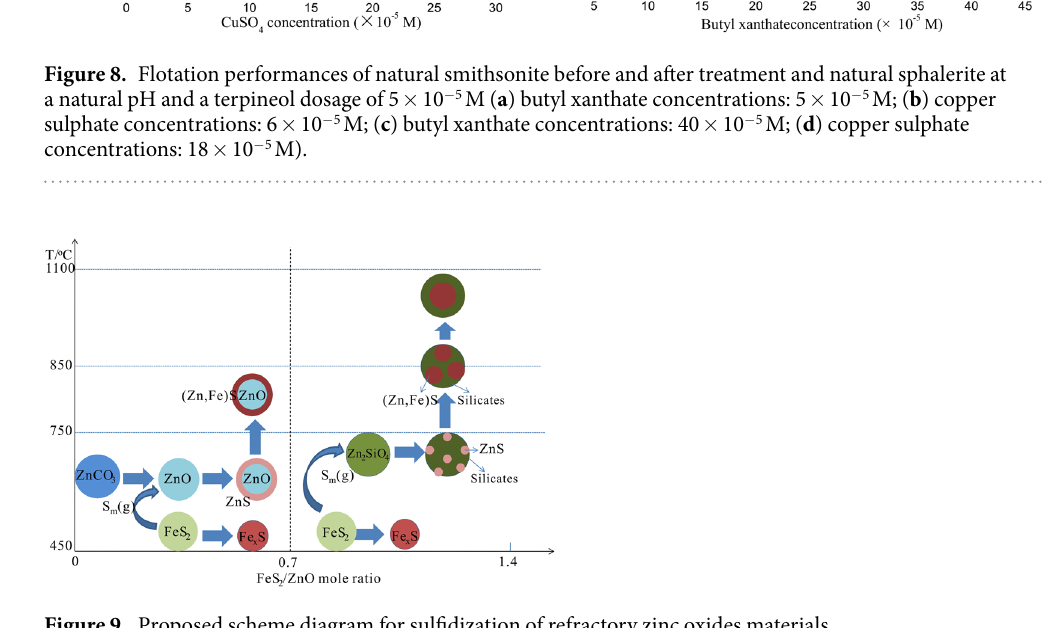
roasting temperature and pyrite dosage. In order to regularize the application of sulfidization roasting to mineral processing, a scheme diagram for the sulfidization of refractory zinc oxides materials was proposed, as shown in Fig. 9. According to the figure, it can be known that recovery of zinc from different zinc materials needed different sulfidization methods. When zinc recovery from the zinc oxide ores, where the zinc mainly exists in form of carbonate, is carried out, surface sulfidization will be reasonable. On the one hand, the FeS 2 /ZnCO 3 mole ratio should be lower than 0.7, which is the critical value in theory for complete transformation of ZnO into ZnS 25 . On the other hand, the roasting temperature should be controlled in the range of 450–750 °C. when the FeS 2 /ZnCO 3 mole ratio nears to 0.7 and even beyond this value, the remaining iron sulfides also reports the flotation concen- trate. In addition, when the roasting temperature beyond 750 °C, the generated ZnS mineral not only aggregated with Fe x S, followed by formation of (Zn, Fe)S compound, but also aggregated with other gangues. Both of which were not beneficial for improving grade of the flotation concentrate. When zinc recovery from the zinc silicate